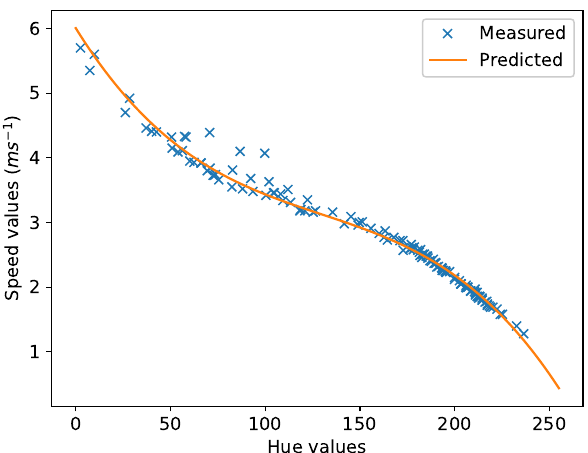
Figure 8. Conversion function of measured hue in image to raw speed value in the elastogram.